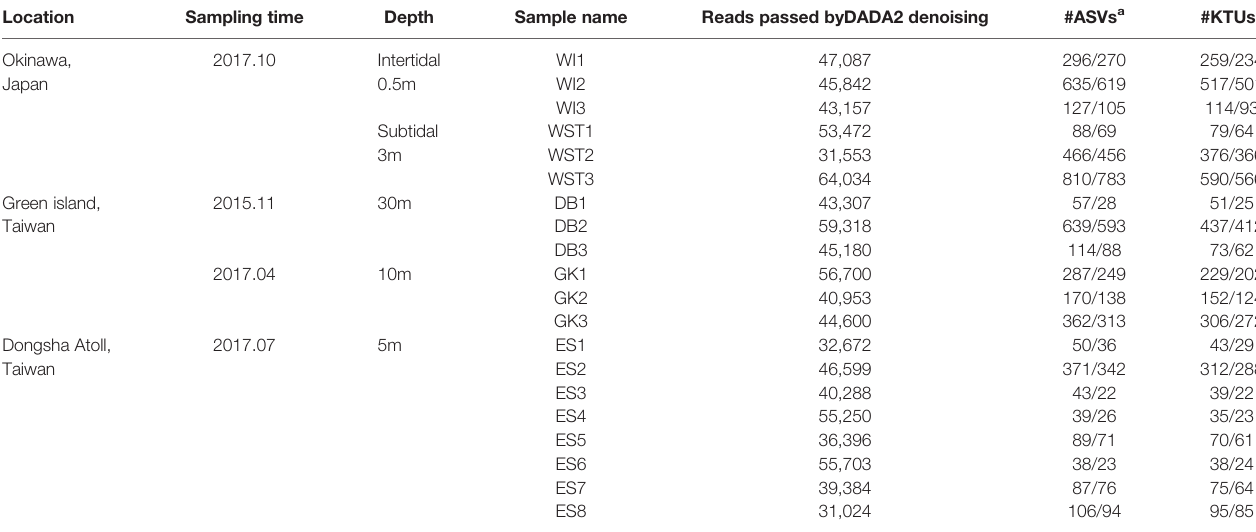
TABLE 1 | Information on Isopora spp. coral colonies used to characterize bacterial communities in different locations.